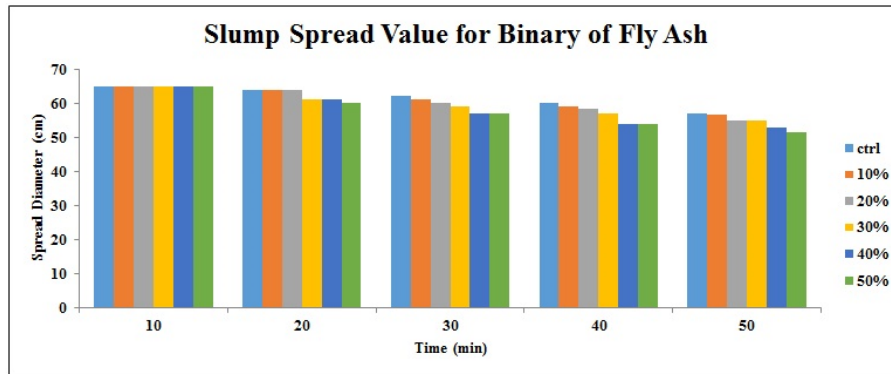
Figure 4. Slump value for FA powder samples throughout the first 50 min.